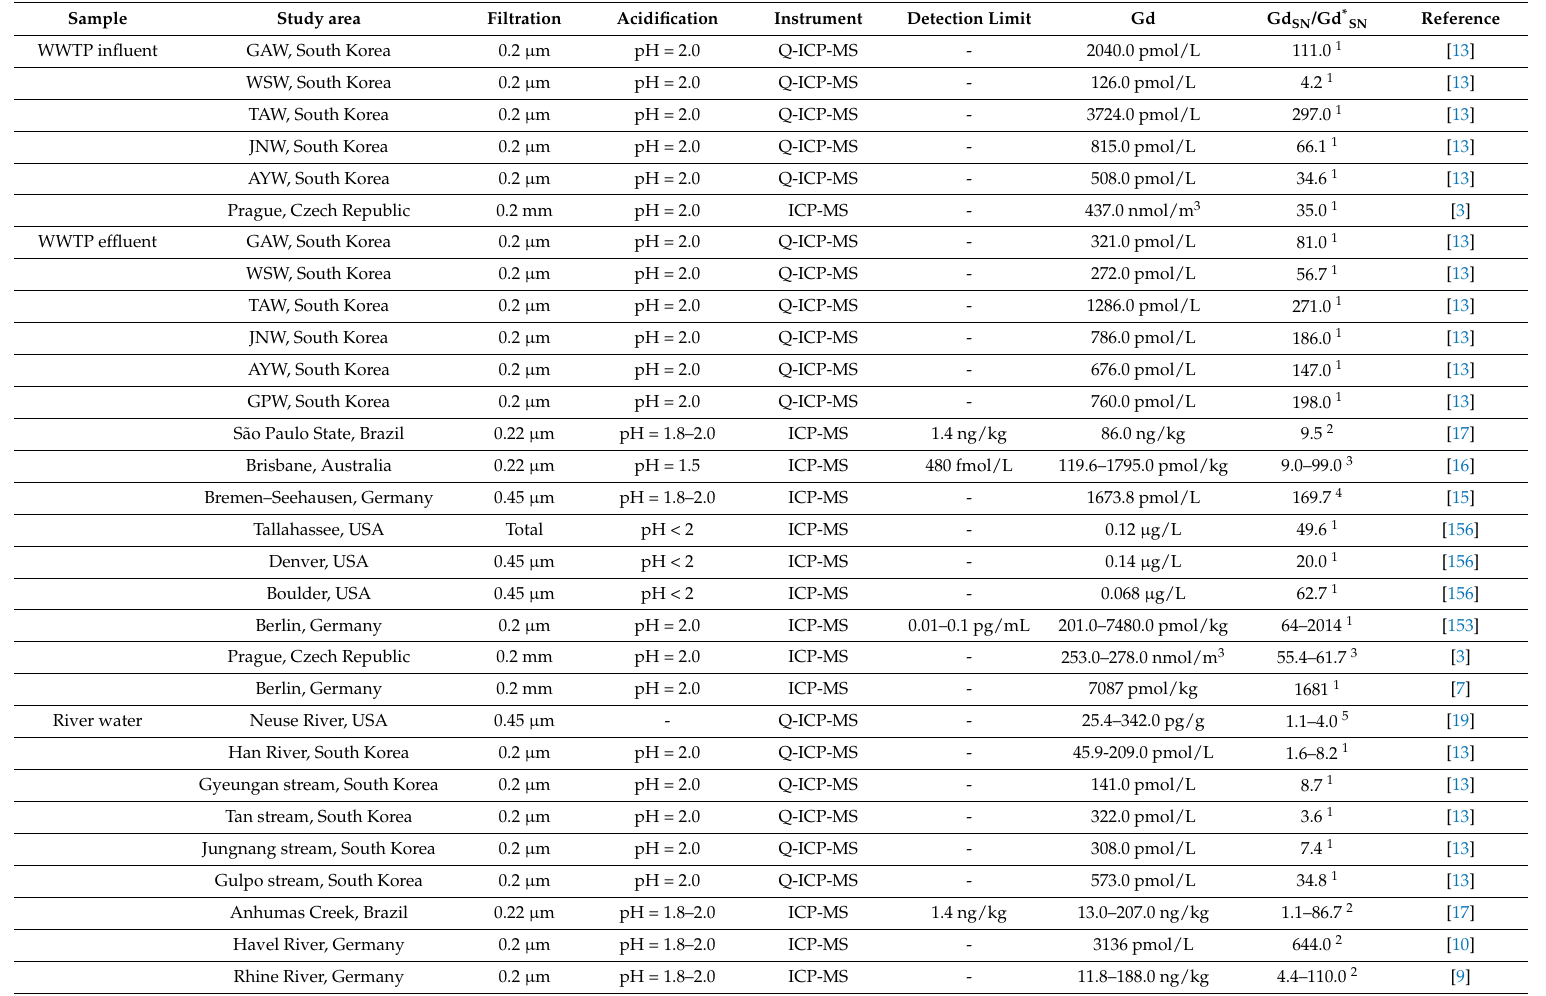
Table 7. Total Gd concentrations and Gd anomalies reported in wastewaters and polluted aqueous samples. The subscript, SN, denotes the normalization to the Gd content in the continental crust (regularly PAAS was used) and the superscript * denotes the natural background